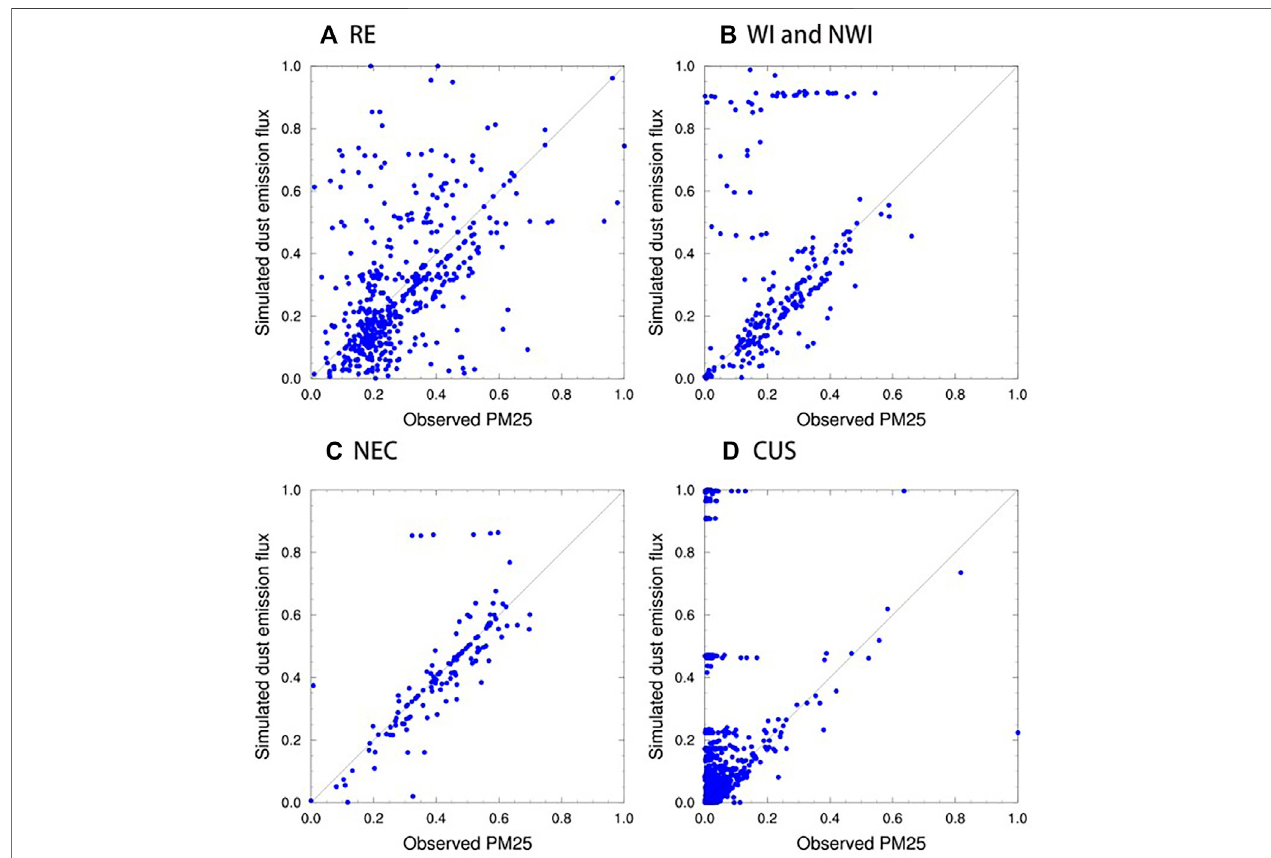
Frontiers in Earth Science |